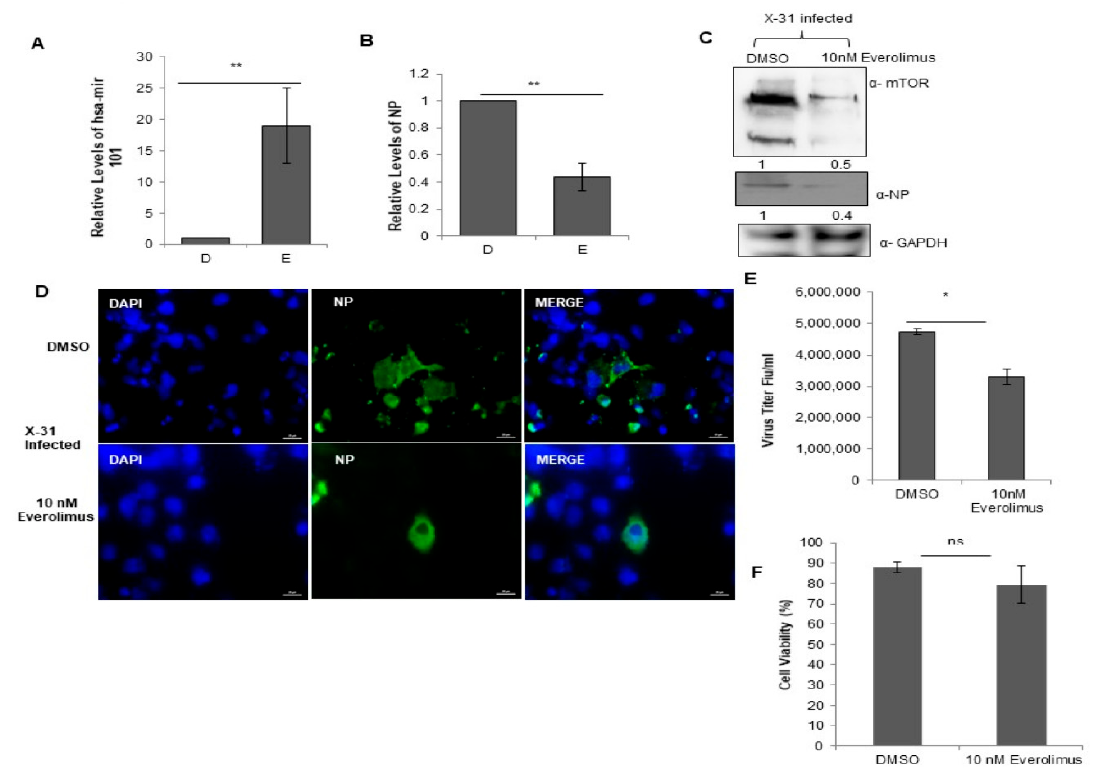
Figure 7. Treatment with Everolimus inhibits IAV infection. ( A , B ) A549 cells were treated with DMSO (0.1%, v / v) and 10 nM Everolimus for 12 h, followed by infection with X-31 at an MOI of 1. The samples were harvested at 24 hpi for extraction of RNA followed by quantification of miR-101 transcripts and NP transcripts. ( C ) A549 cells were treated with DMSO and 10 nM Everolimus for 12 h, followed by infection with X-31 at an MOI of 1. Samples were collected at 24 hpi and were resolved on SDS-PAGE for the detection of mTOR, NP and GAPDH. ( D ) A549 cells were treated with DMSO (0.1%, v / v) and 10 nM Everolimus for 12 h, followed by infection with X-31 at an MOI of 5. The cells were fixed 24 hpi. Nuclei were stained with DAPI (Blue). NP was detected using goat anti-mouse-conjugated to Alexa-488 (green). Scale is 20 µ m. ( E ) A549 cells were treated with DMSO (0.1%, v / v) and 10 nM Everolimus for 12 h, followed by infection with X-31 at an MOI of 1 for 48 h followed by determination of viral titers by flow cytometry analysis with anti-NP antibody conjugated to Alexa Fluor 488. ( F ) A549 cells seeded in 96-well plate were treated with DMSO (0.1%, v / v) and 10 nM Everolimus. Cell viability was determined by MTT assay 24 h after treatment. The data in A, B, E and F is shown as mean ± S.D. of three independent experiments. * and ** indicate statistically significant di ff erences at p < 0.05 and p < 0.01, respectively. ns denotes non-significant.